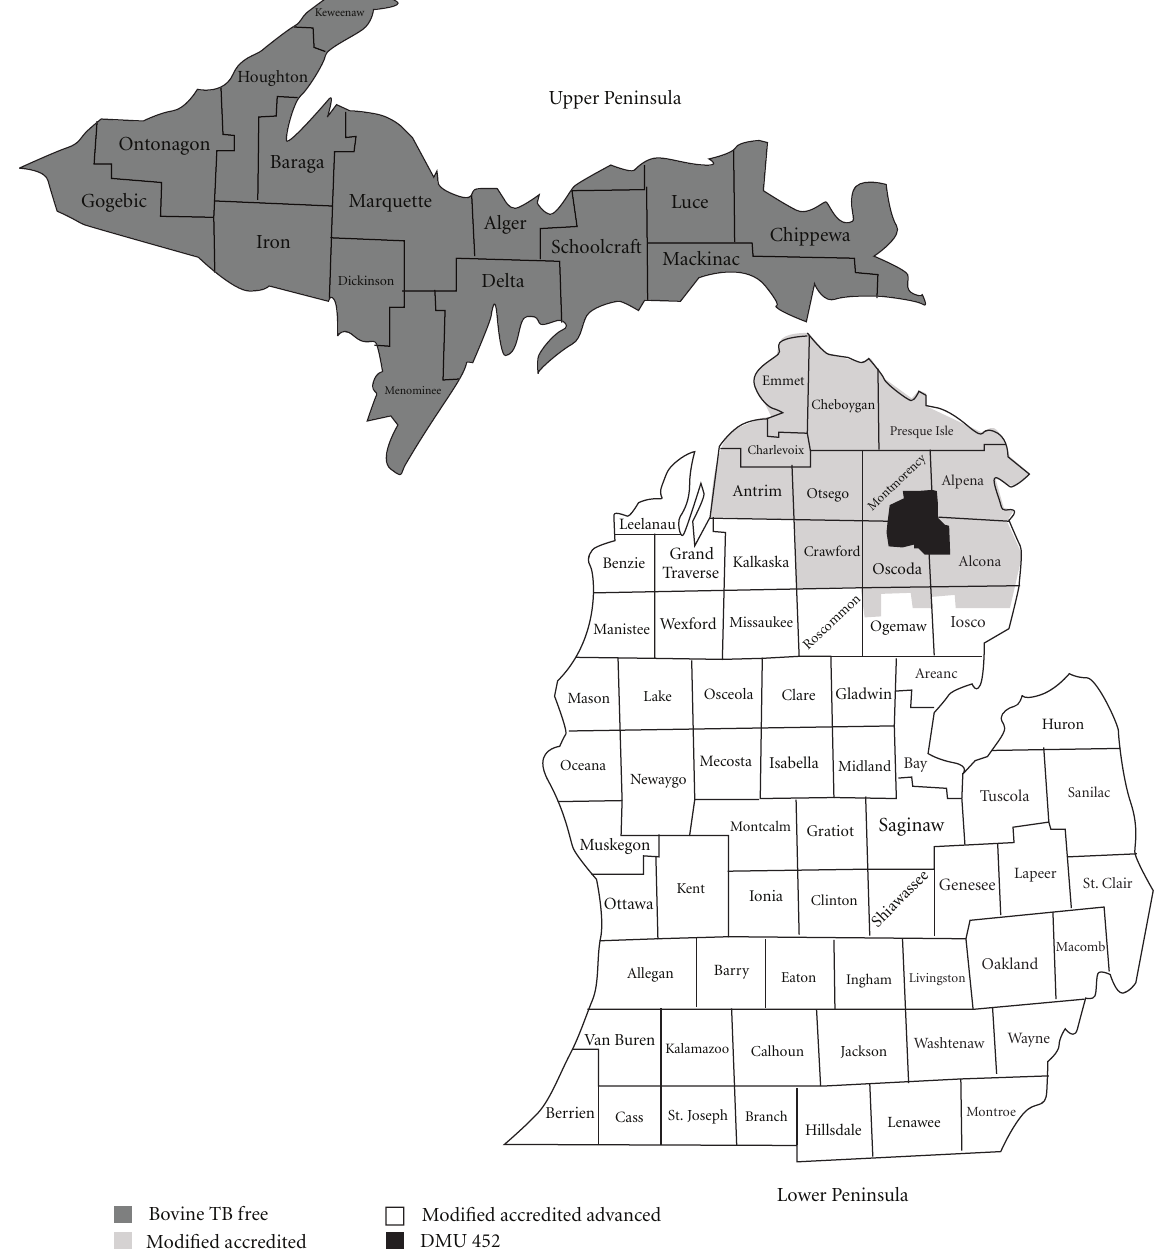
Figure 1: State of Michigan map showing the Upper and Lower Peninsula, counties, and BTB zones as of December 2009.